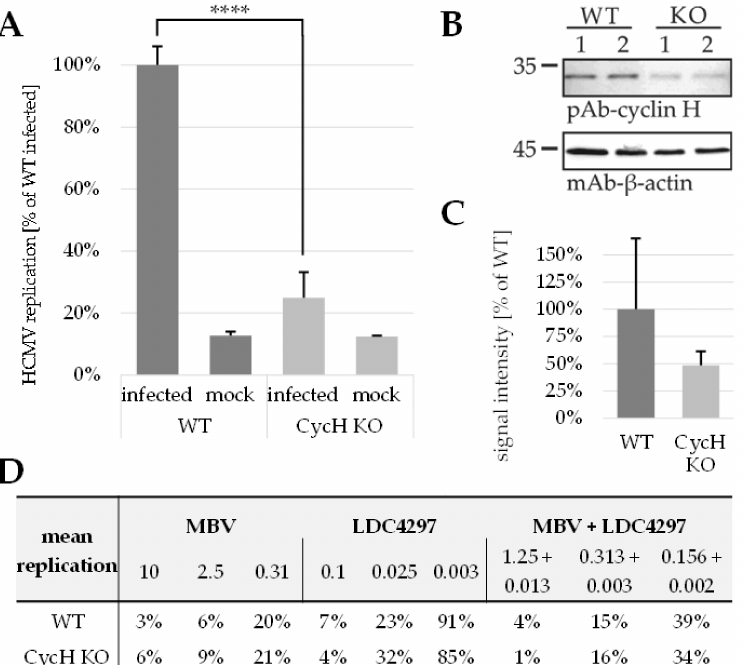
Figure 6. Replication of HCMV AD169-GFP is significantly reduced in HFFs with a partial cyclin H knock-out. ( A ) Comparison of HCMV replication in wild-type (WT) and cyclin H knock-out (KO) HFFs. One day after seeding, cells were treated with lentiviral supernatants for 24 h, then incubated with fresh media for 24 h, subsequently infected or mock-infected and harvested after 7 d. Data are presented as mean of biological duplicates + SD. Note that the basal signal level obtained with mock-infected samples results from excitation/emission background usually produced by the automated GFP fluorometry. Statistical analysis was performed using ordinary one-way ANOVA and posthoc Tukey’s test. ( B ) Western blot data of HFF lysates measured in A. ( C ) Densitometric analysis of Western blot bands shown in B. Data are presented as β -actin-adjusted mean densitometric values of two double-quantified bands + SD, relative to signal intensity of WT. ( D ) Mean replication values (in % solvent control) of antiviral drug treatments (in µ M), compared between WT and CycH KO